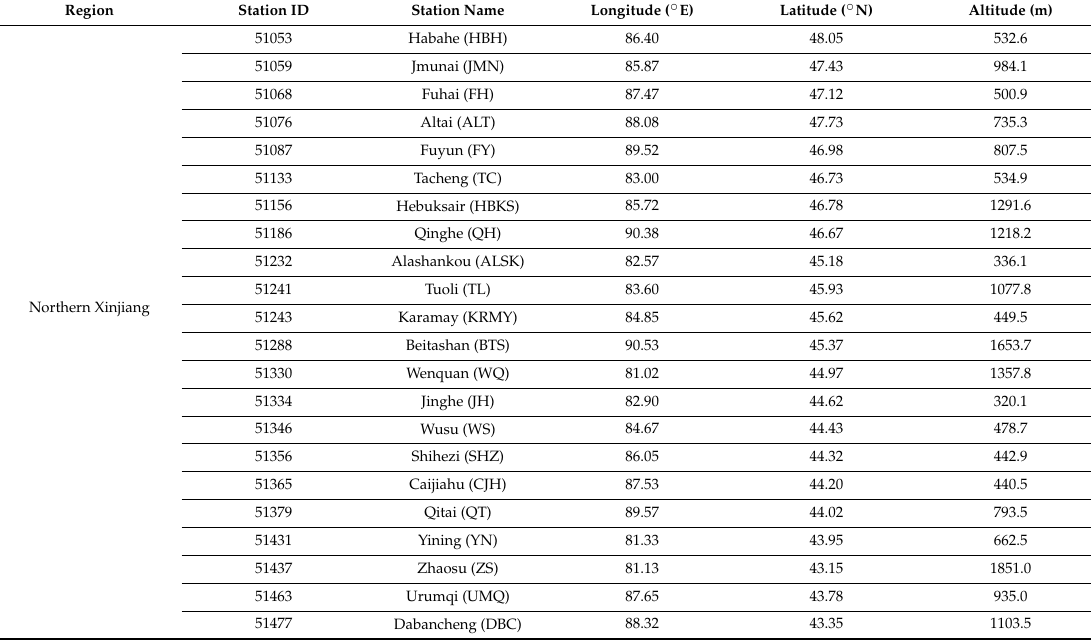
Table 1. Information of the meteorological stations used in this